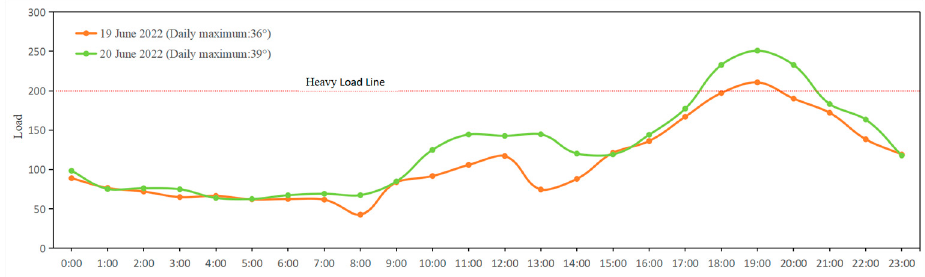
Figure 5. The load curve of a public transformer at different maximum temperatures.